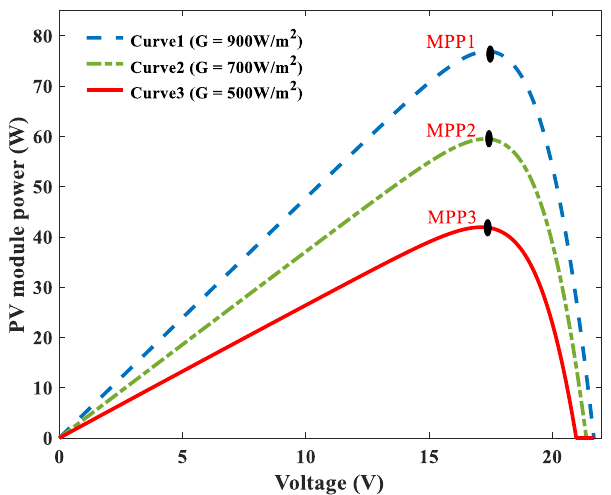
Figure 9. P-V characteristics of the test